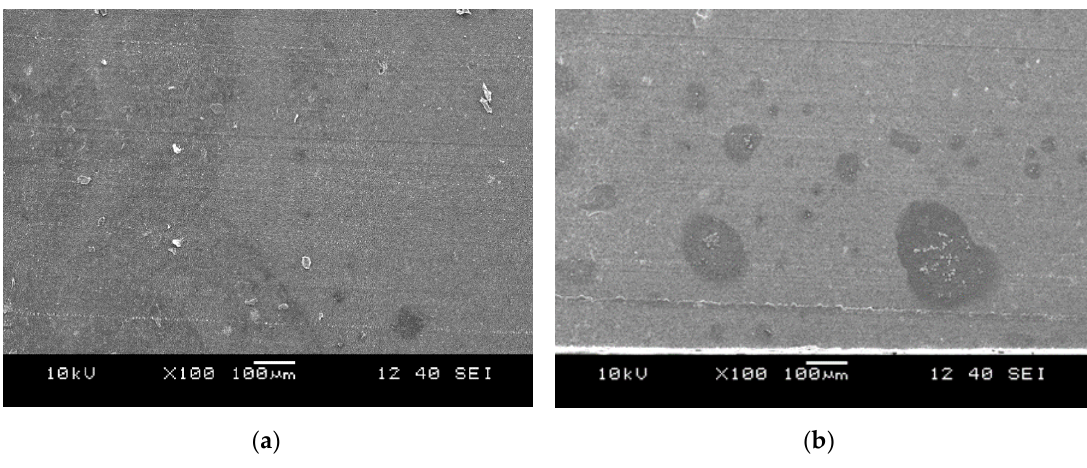
( b ) Figure 10. Cryomicrotomed surfaces of the TDVs with different PP feeding methods and higher compounding temperature profile: ( a ) Side feeding with 180 °C melt temperature ( A_S_H_2_50 MR) ; ( b ) Hopper feeding ( A_H_H_0_50 MR). The comparison of the images displayed in Figures 9 and 10 shows that increasing the compounding temperature (Figure 9a: compounding temperature profile: L; Figure 10a: compounding temperature profile: H) resulted in a refinement of the rubber dispersion similar to the modification of the screw configuration. Hopper feeding of the PP had a similar, but additional refining effect on the dispersion of the rubber in the TDV. This may be caused by the rapid curing of the rubber phase at the zone, where the PP was introduced to the compounding extruder in the case